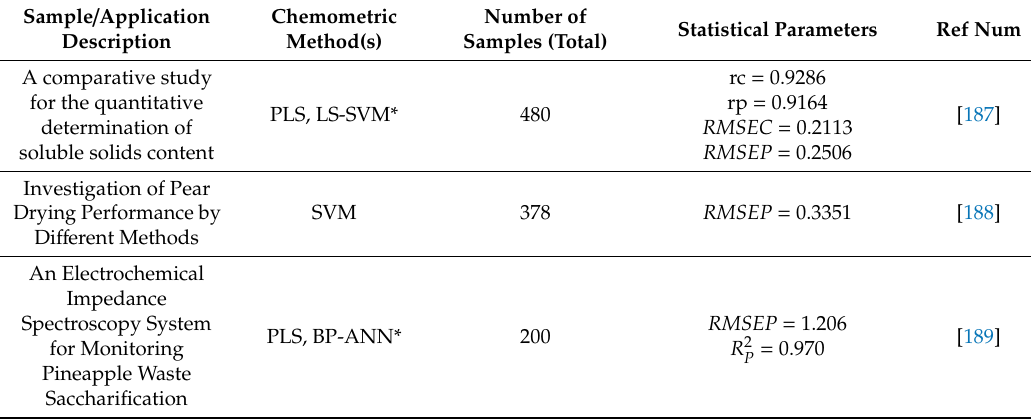
Table 9. Literature related to the use of chemometrics in prediction of properties of